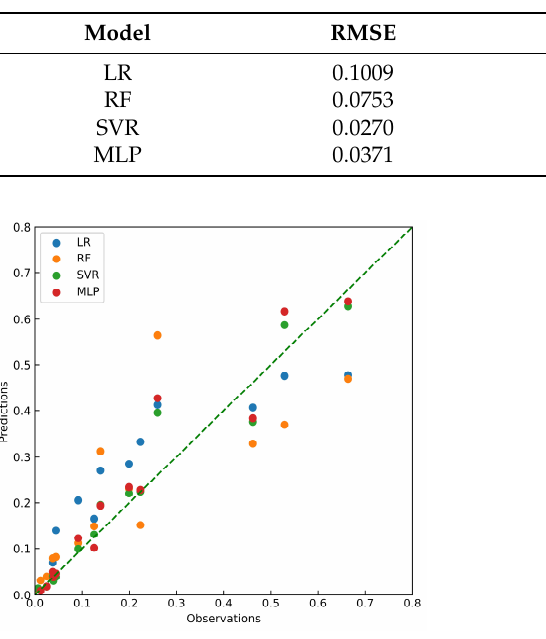
Figure 5. Predictions vs observations plots for all proposed regression models.